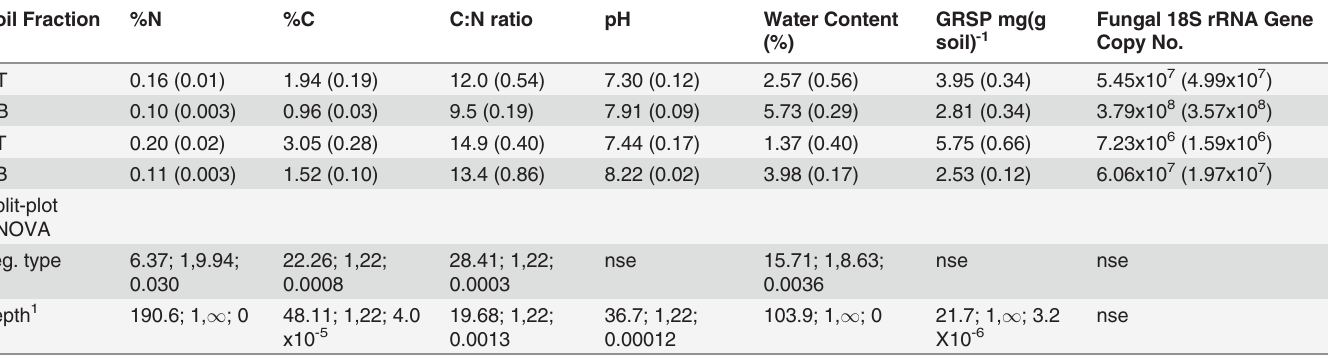
Table 1. Average (n = 6 ( ± 1 standard error)) physical, chemical and biological properties of soil intervals and the results of a split-plot